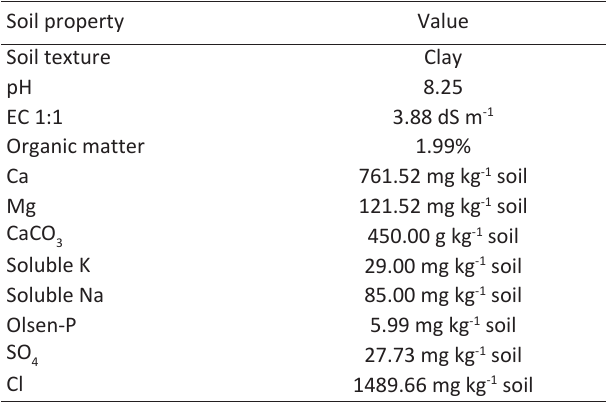
Table 1 - Chemical properties of the soil brought from the southern Jordan Valley Soil property